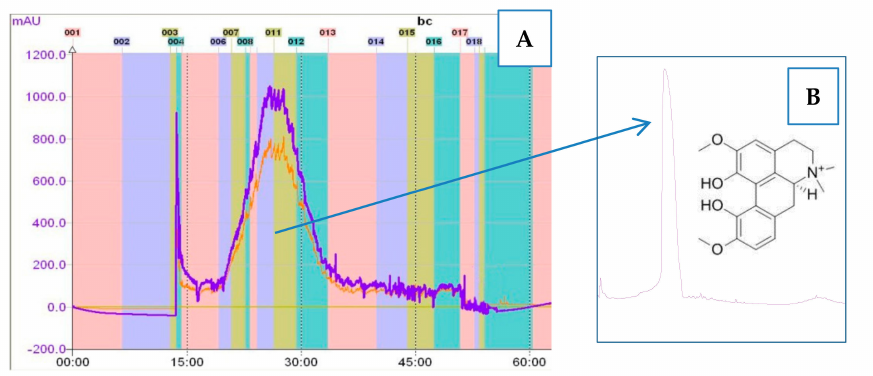
Figure 2. The part of counter-current partition chromatography (CPC)-UV chromatogram (at 290 nm) of the Berberis cretica root extract that show the elution of magnoflorine (MGN) ( A ) and the total ion chromatogram (TIC) of the isolated MGN ( B